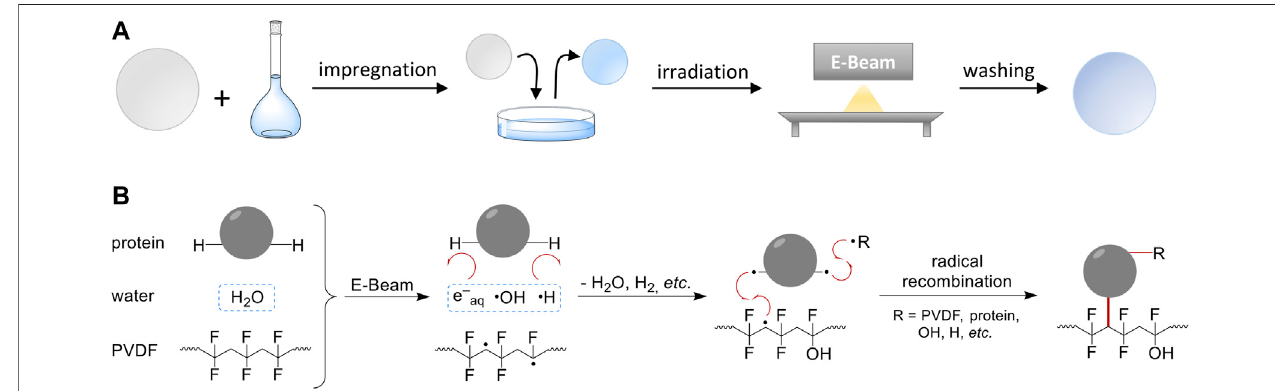
FIGURE1 | Scheme ofthe general method and proposed reaction mechanism. (A) TheRIGI process solely utilizes apolymermembrane and an aqueous solution of the modifying compound (here: BSA). The membrane is impregnated with the aqueous solution. In case of hydrophobic polymers, a pre-wetting step has to be included. Finally, irradiation with electron beam and washing is performed. (B) Simpli fi ed scheme of the proposed reaction mechanism according to recent studies (Schmidt et al., 2021).Electron beam irradiation results inthe formationofactive speciessuchasPVDFmid-chain radicals,and water radiolysis products, primarily solvated electrons, OH radicals, and H radicals. Due to its low abundance ( ω ≤ 2%), the radiation chemistry of the protein is of minor importance. Immediately, water radiolysis products react with the solute, e.g. , via H abstraction, to form protein radicals. Finally, radical recombination reactions lead to covalent coupling between protein molecules and polymer